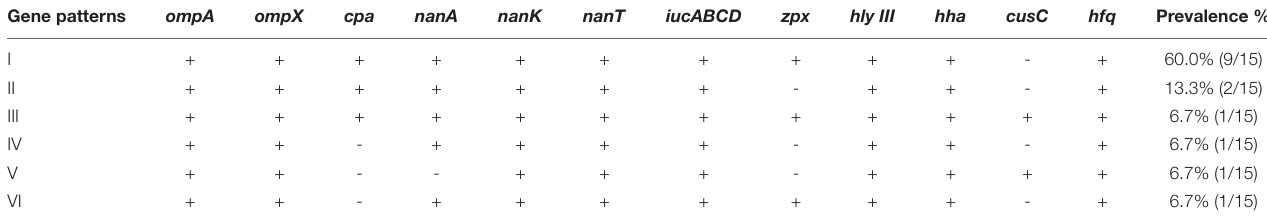
TABLE 3 | Patterns of virulence genes distribution in C. sakazakii